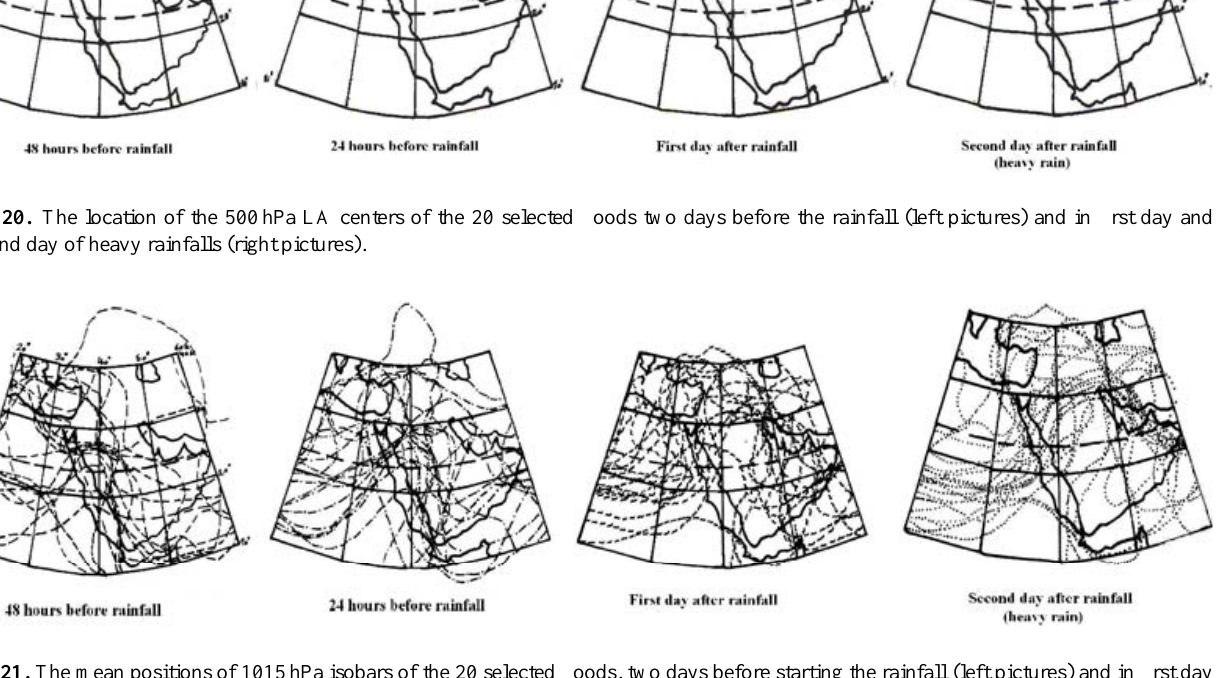
and second day after heavy rainfalls (right pictures).